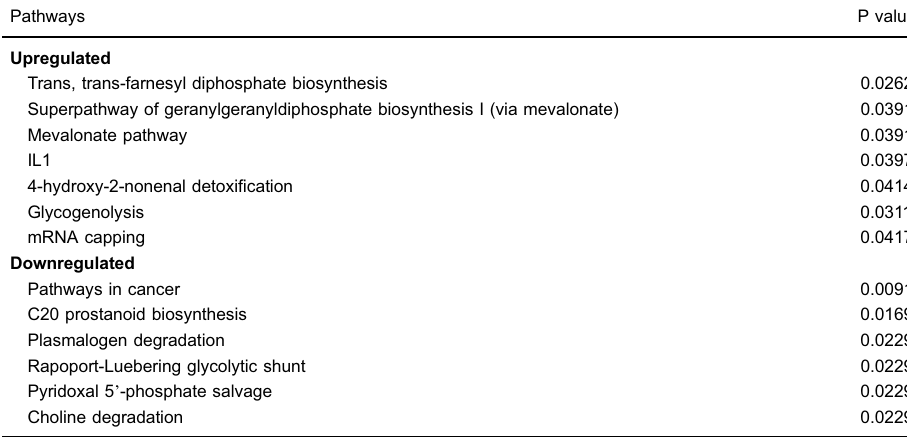
Table 4. Pathway analysis of differentially expressed genes from AHOL1 cell line. Pathways